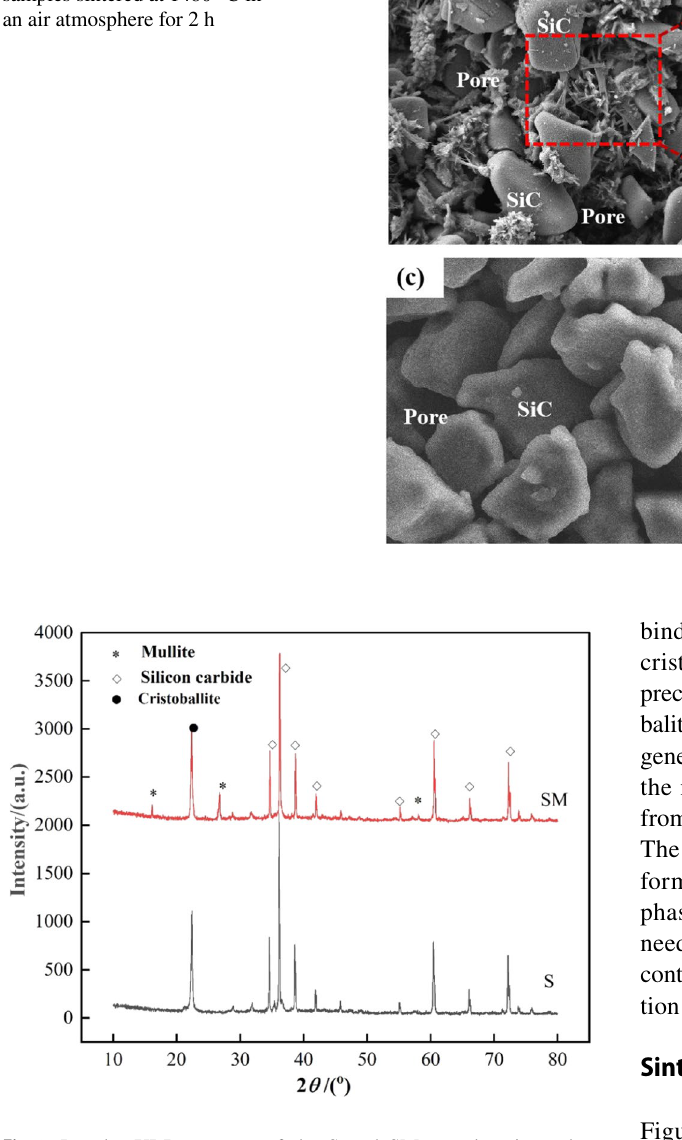
Fig. 3 Powder XRD patterns of the S and SM samples sintered at 1480 °C in an air atmosphere for 2